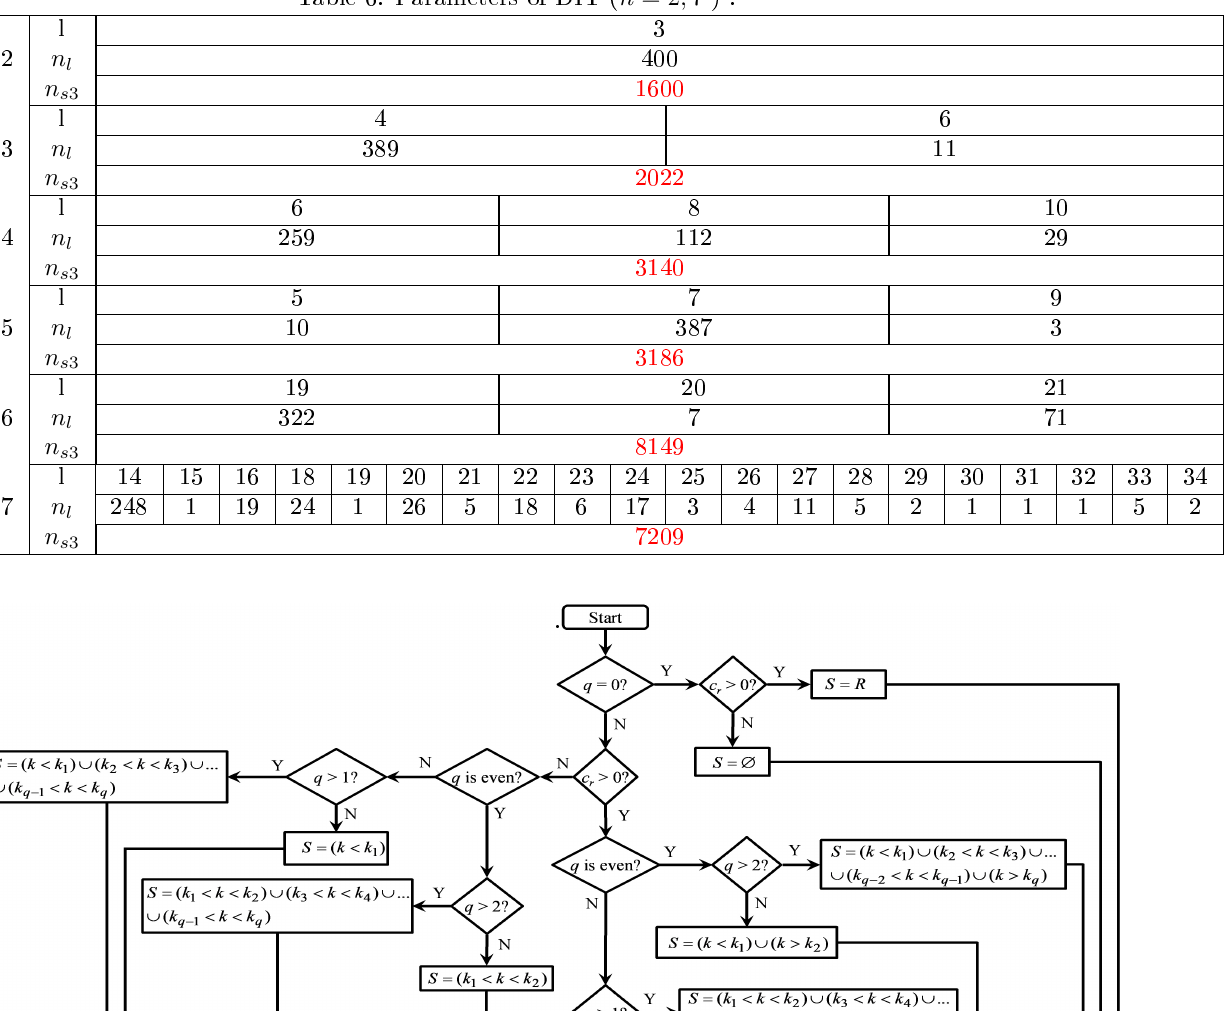
Table 6. Parameters of DIT ( n = 2 , 7 ) .